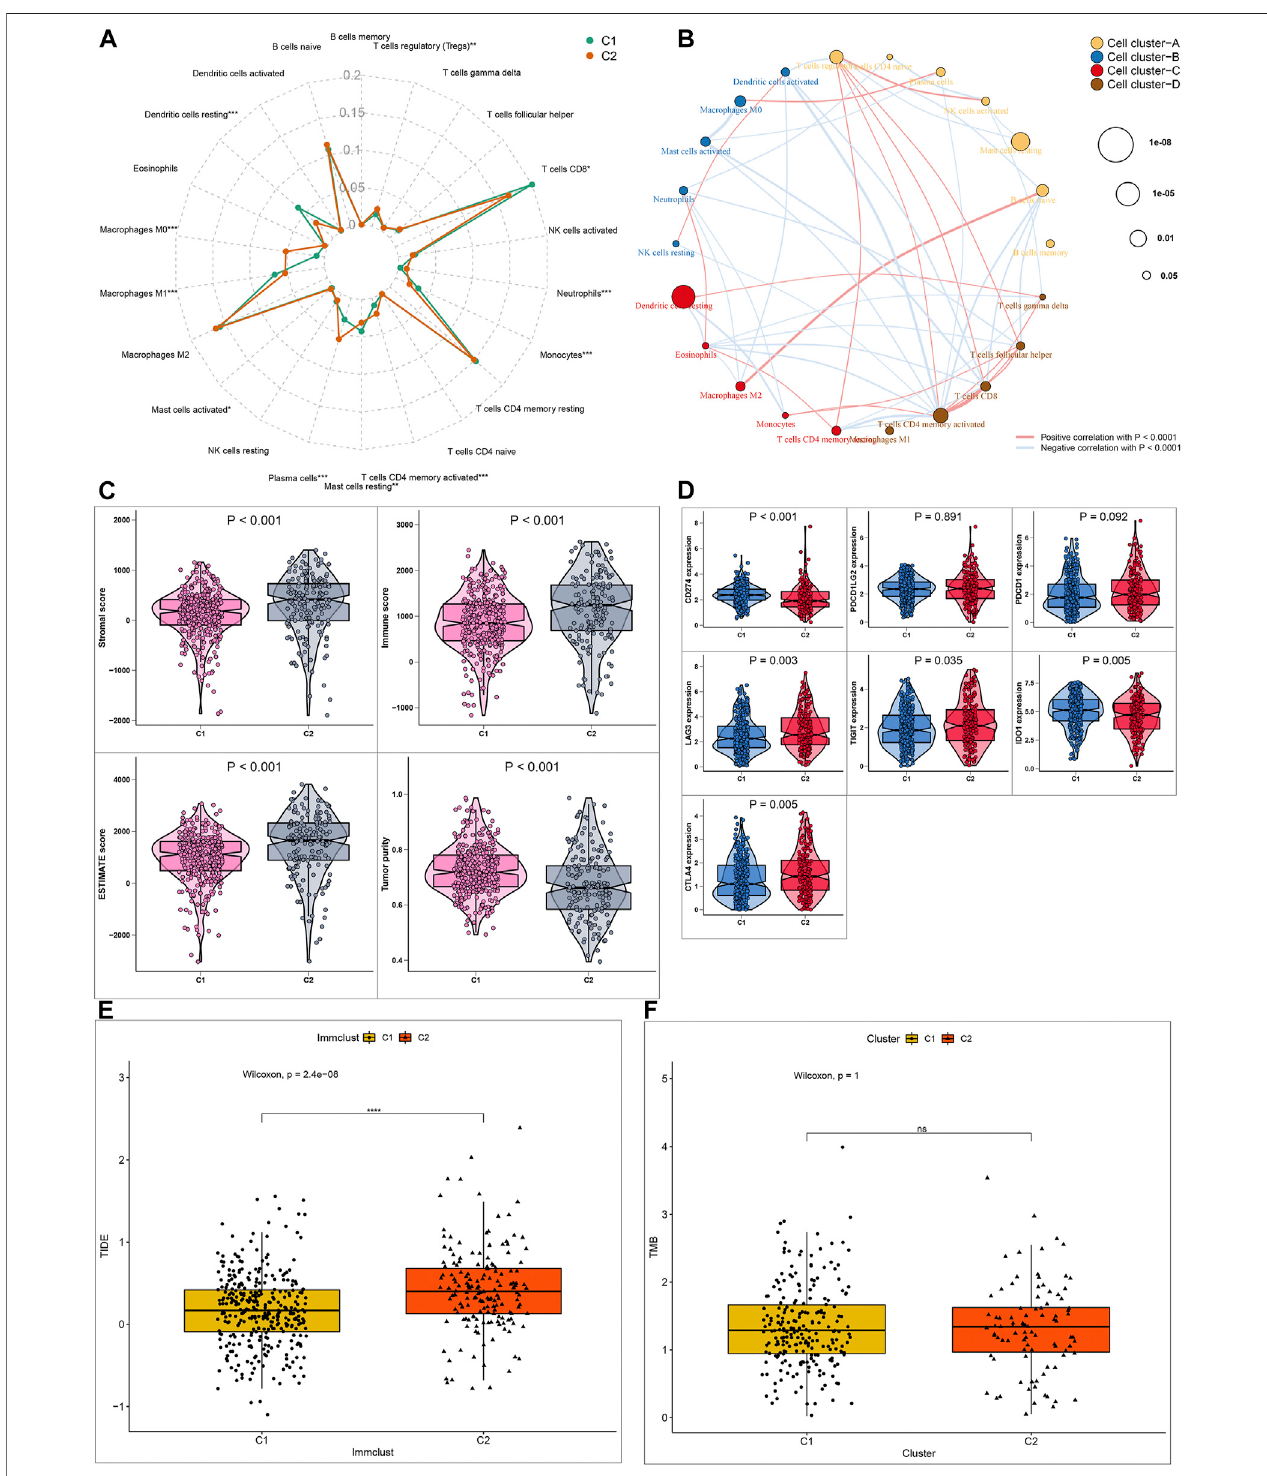
FIGURE3| Differentialsensitivity toimmunotherapybetweentwoccRCCmolecularsubtypes (A) Radarmapshowingthedifferencesinproportionsof22immune cell types between C1 and C2 molecular subtypes (B) A network of the correlation between the levels of 22 kinds of tumor-in fi ltrating immune cells in ccRCC samples. The size of bubble is inversely proportional to p -value (C) Patternsof stromal cell scores, immunecell scores, ESTIMATE scoresand tumor purity between subtypes (D) Expression levels of immune checkpoint markers in the two subtypes (E, F) Box plots showing the correlation between TIDE/TMB levels and molecular subtypes. * p < 0.05; ** p < 0.01; *** p < 0.001; **** p < 0.0001; ns: no statistical signi fi cance.